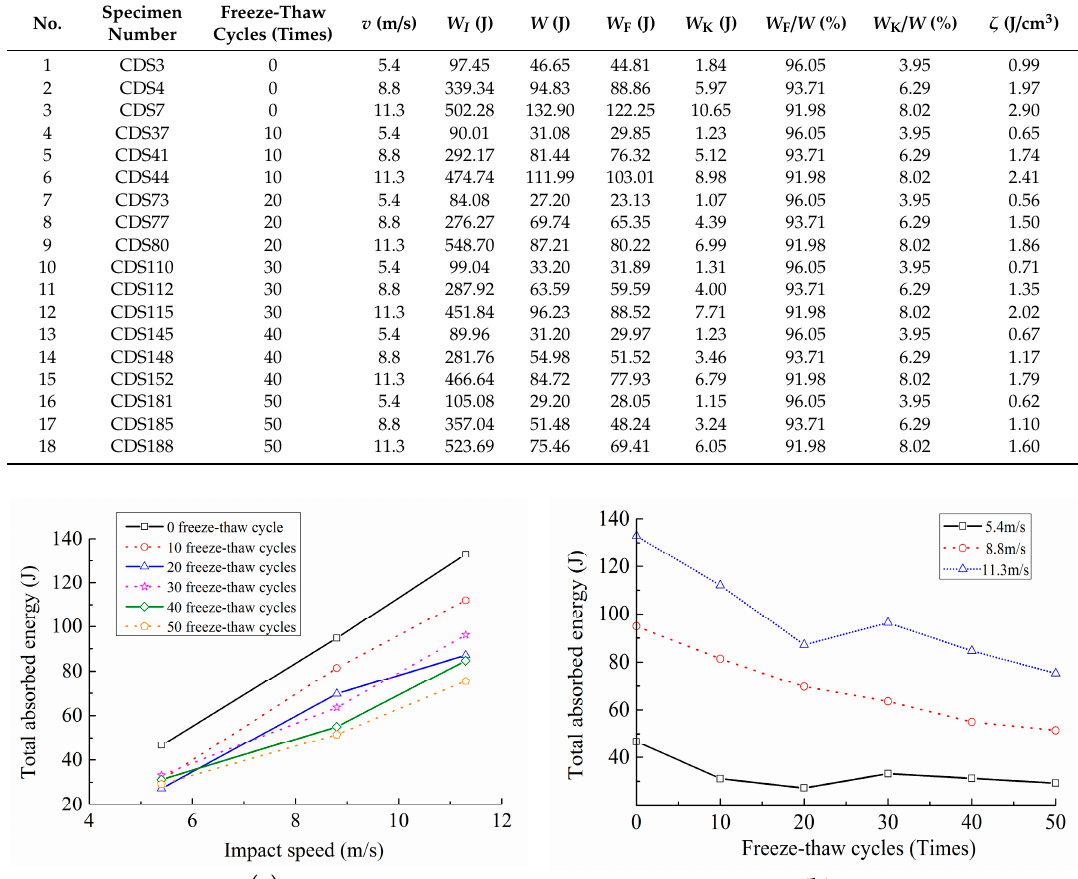
Table 6. Calculation results of the energy consumption under di ff erent conditions.